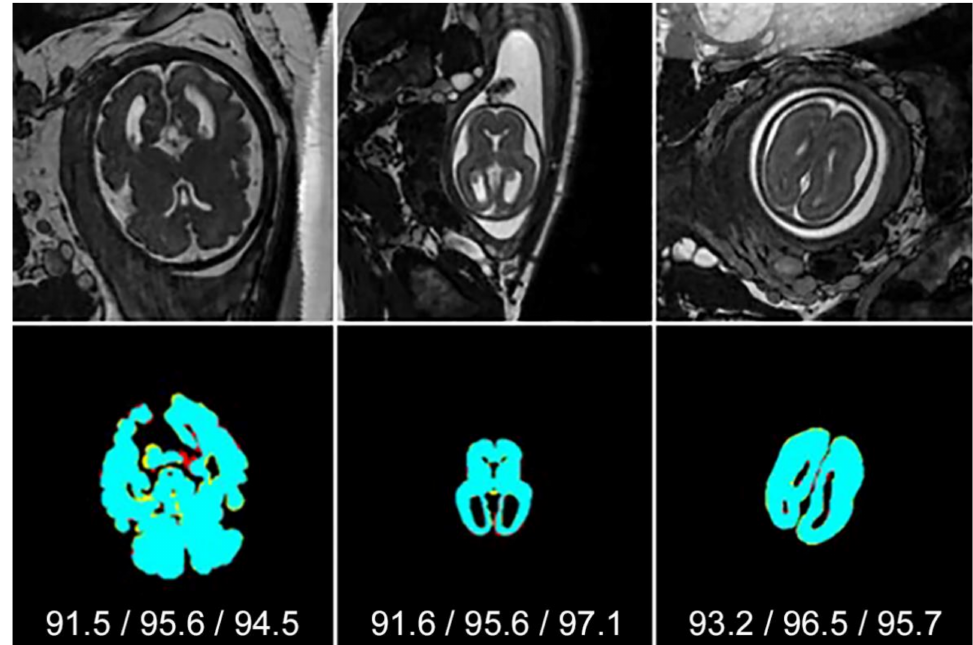
Figure 3. Typical examples of P AVG segmentation results from middle slices. Black, cyan, red and yellow represent TN , TP , FP and FN , respectively. Jaccard/Dice/Sensitivity scores are shown under each segmentation.